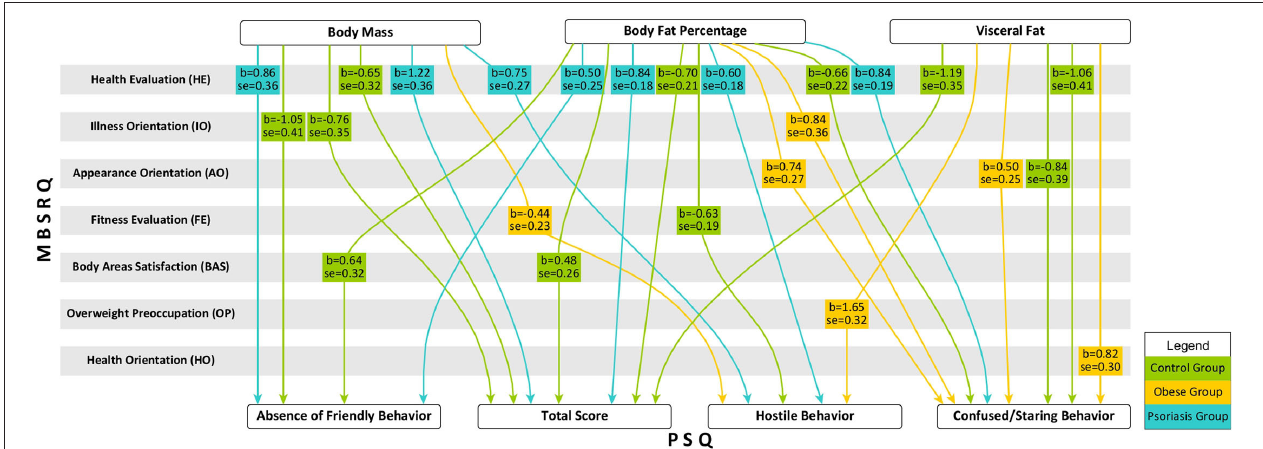
FIGURE 1 | Moderation effect of body image on relation between objective body dimension and perceived stigma.